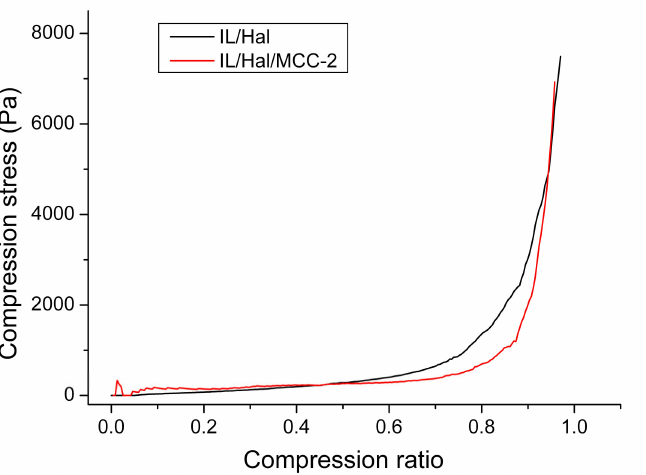
Figure 9. Dependence of the compression stress on the degree of deformation for the IL/Hal and IL/Hal/MCC